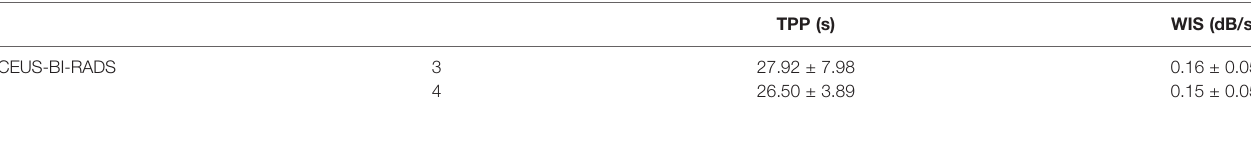
TABLE 3 | CEUS-BI-RADS Categories,TTP and WIS Values of Patients with GLM.